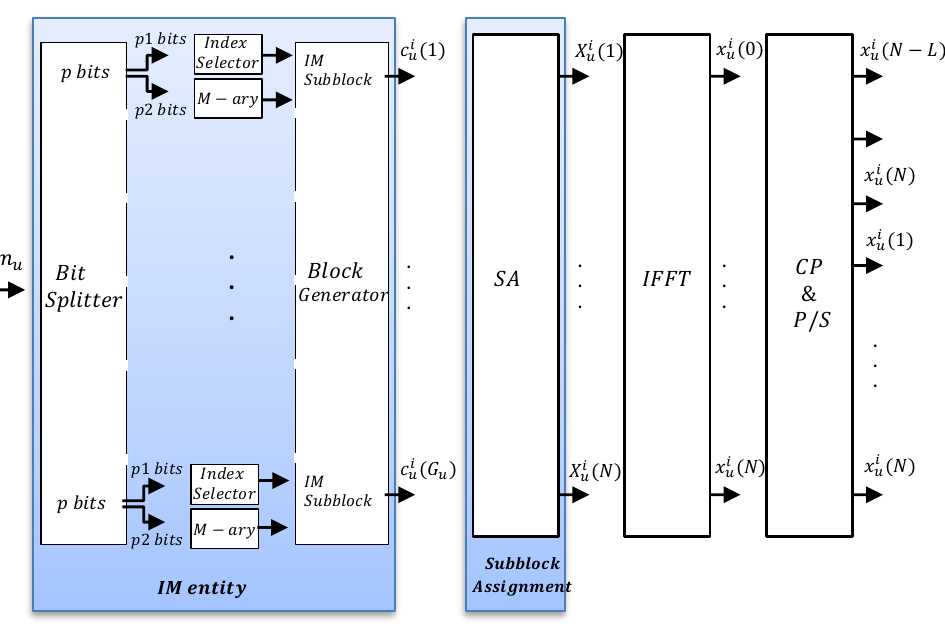
Figure 4. Block diagram of asynchronous OFDM-IM transmitter for i -th block of u -th